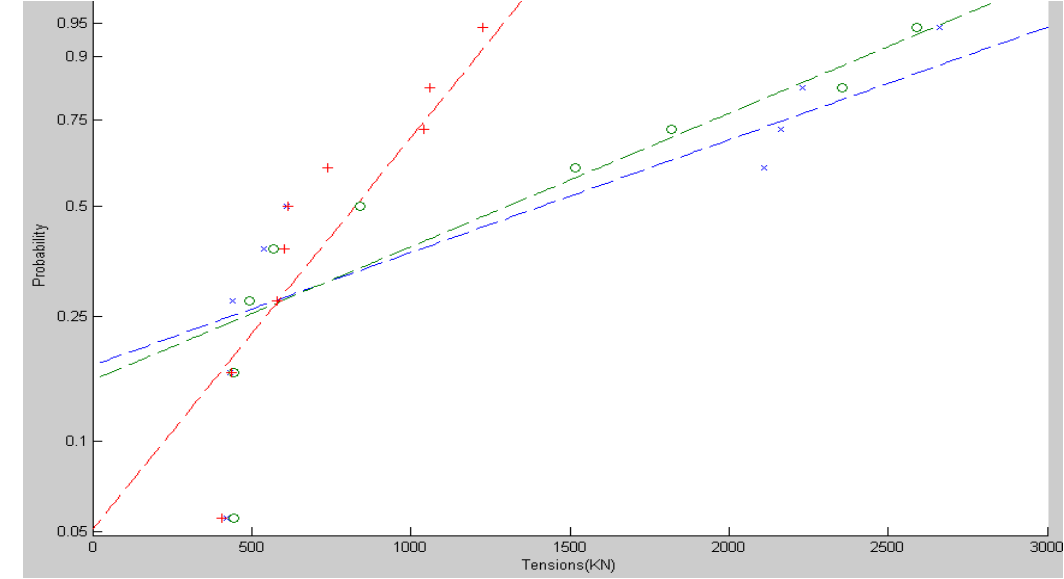
Figure 7. Comparison of extreme peak mooring tensions induced at different WEC array configurations in short crested seas. Data < 400 KN were excluded from this analysis. Crosses and Blue Line: 5 WEC array (test 7020); Circles and Green Line: 3 WEC array (test 5020); Pluses and Red Line: single WEC installation (test